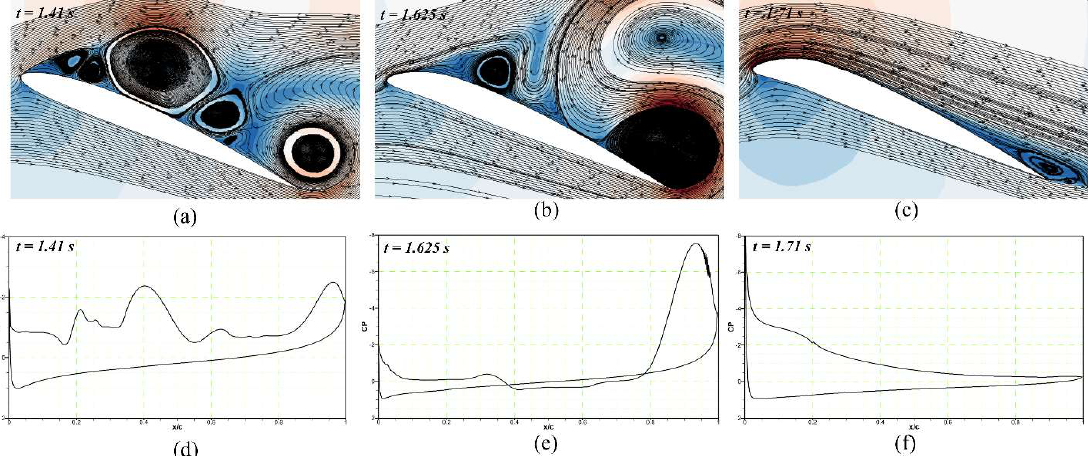
Figure 22. The downward deflection of the DMLE airfoil shows the ( a ) velocity streamline contours at time step of 1.41 s, ( b ) velocity streamline contours at time step of 1.625 s, ( c ) velocity streamline contours at time step of 1.71 s, ( d ) pressure coefficient at time step of 1.41 s, ( e ) pressure coefficient at time step 1.625 s and ( f ) pressure coefficient at time step of 1.71 s. These figures reveal the velocity stream lines with their respective pressure coefficients at different morphing leading edge deflections and how the flow stability increases by minimizing the flow separation over an airfoil.